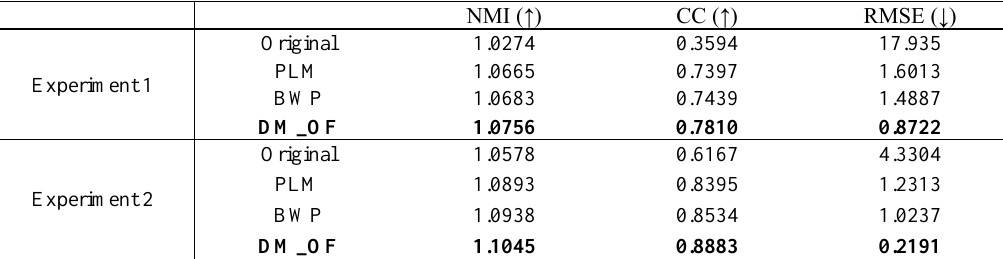
Table 1. Quantitative evaluation of the experiments NMI (↑) CC (↑) RMSE